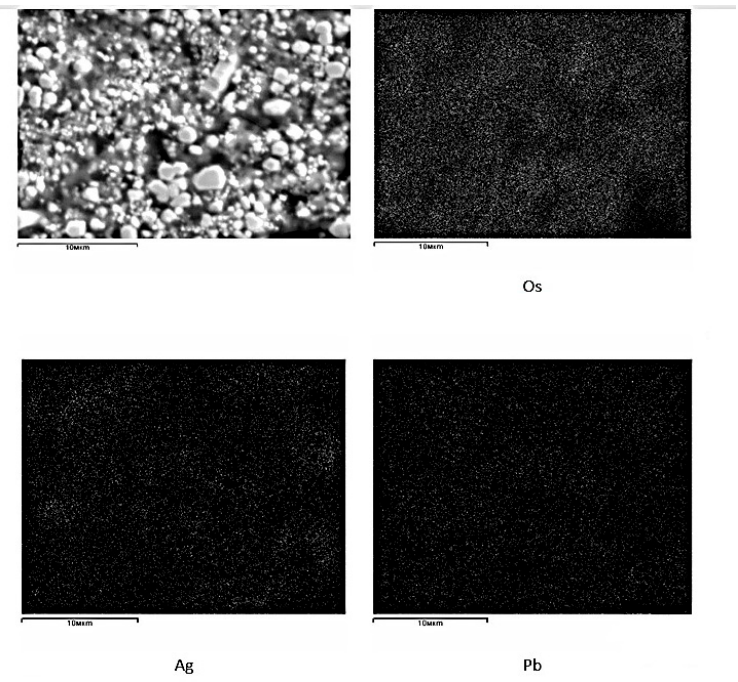
Figure 7. Microstructure and distribution density of elements in the concentrate. Table 6. Results of microprobe elemental analysis of various phases of osmium concentrate, %.